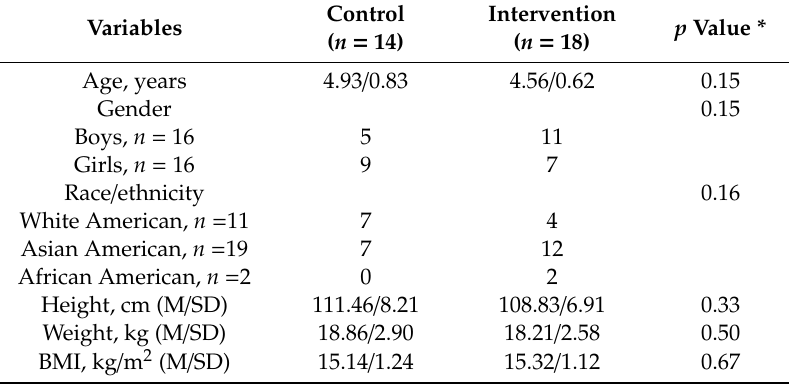
Table 1. Characteristics of children.